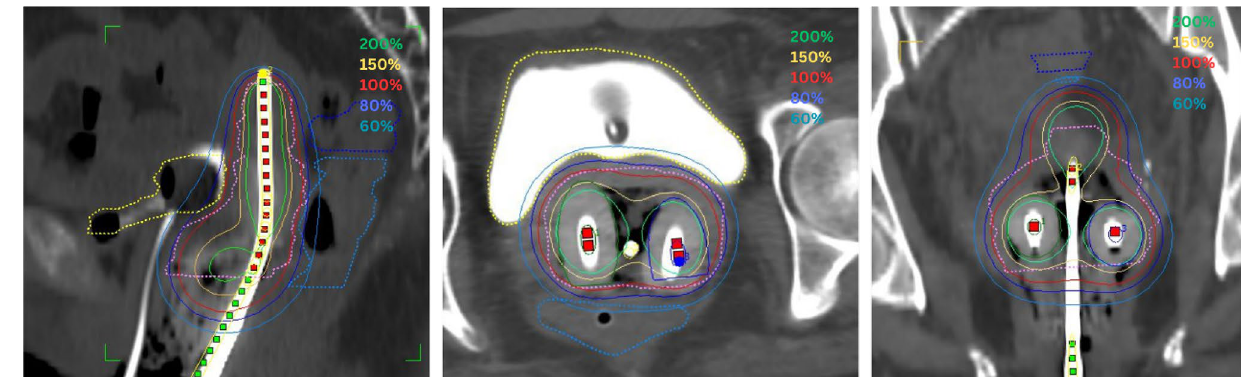
Fig. 2 CT scan with Brachytherapy applicator in